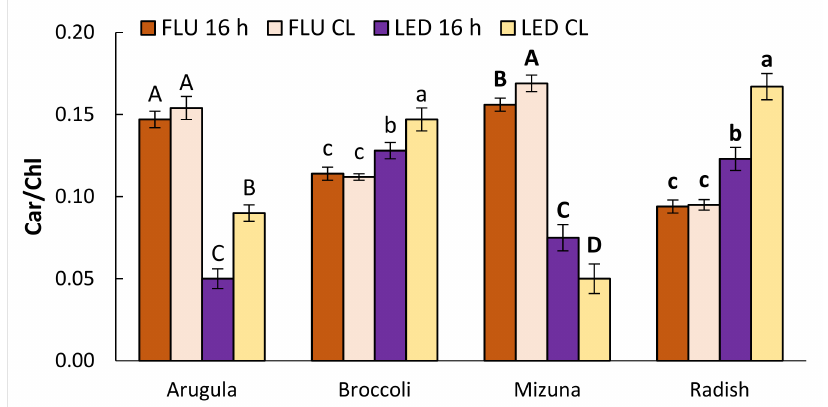
Figure 3. The ratio of carotenoid to chlorophyll content of arugula, broccoli, mizuna, and radish microgreens grown under 16 h photoperiod or CL provided by fluorescent (FLI) or LED lamps. The results are presented as the mean ± standard error. Different letters for each parameter and plant species indicate significant differences between the mean values at p <